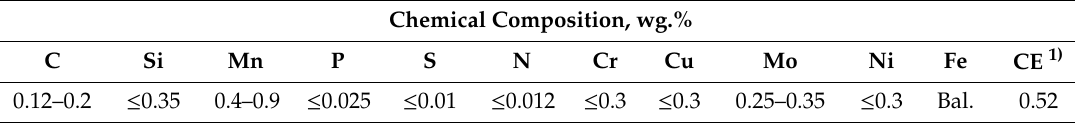
Table 1. Chemical composition of 16Mo3 steel according to manufacturer data (Margo Ltd., Stalowa Wola,